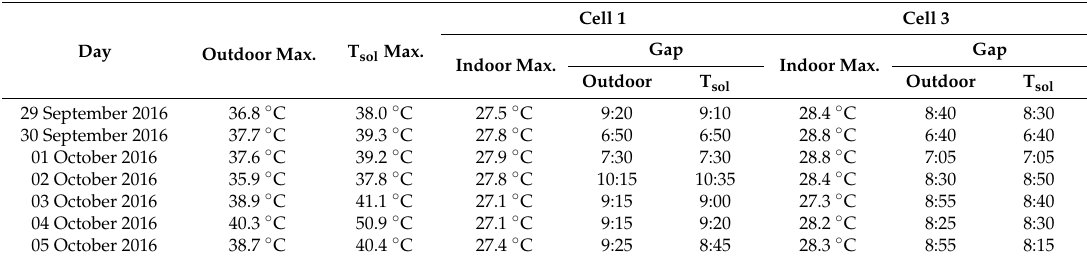
Table 10. Air ambient temperature in Cells 2 and 4.